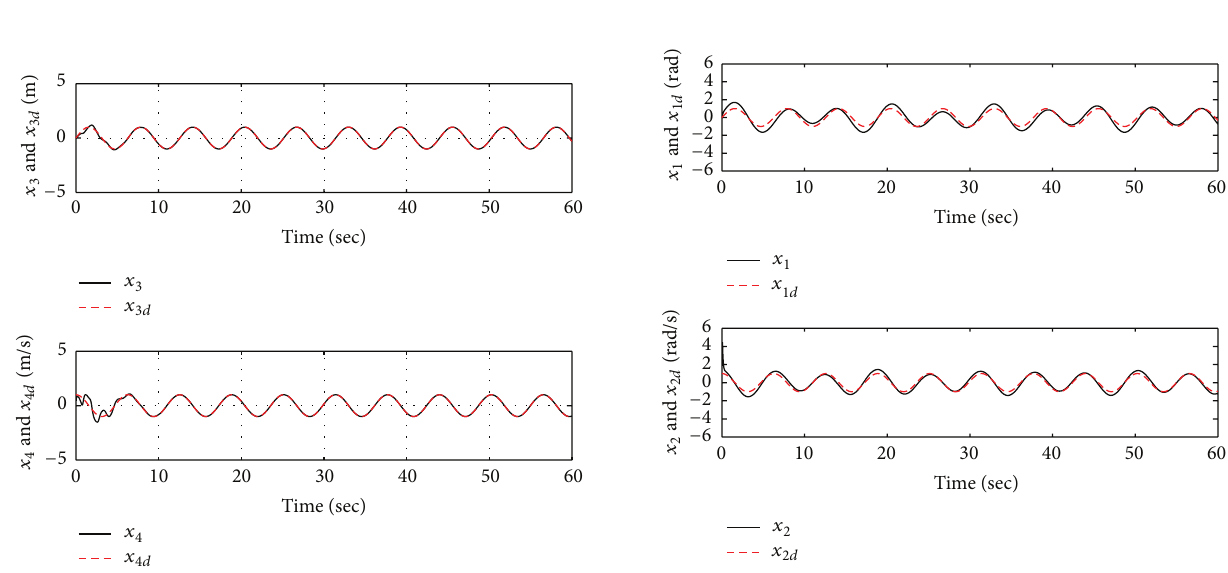
Figure 6: The tracking performances of 𝜃 and